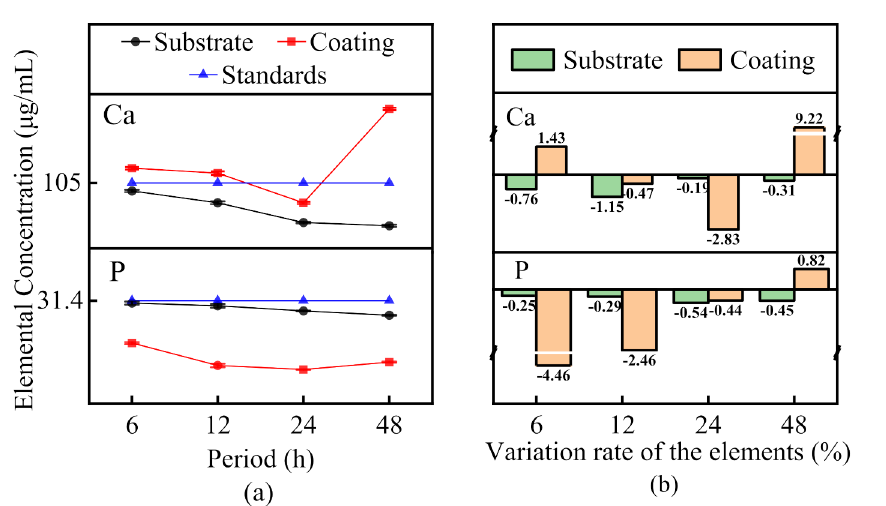
Figure 12. Concentrations of Ca and P in the immersion solution ( a ), the variation rate of the elements ( b ) during the immersion period of the coating and Ti6Al4V